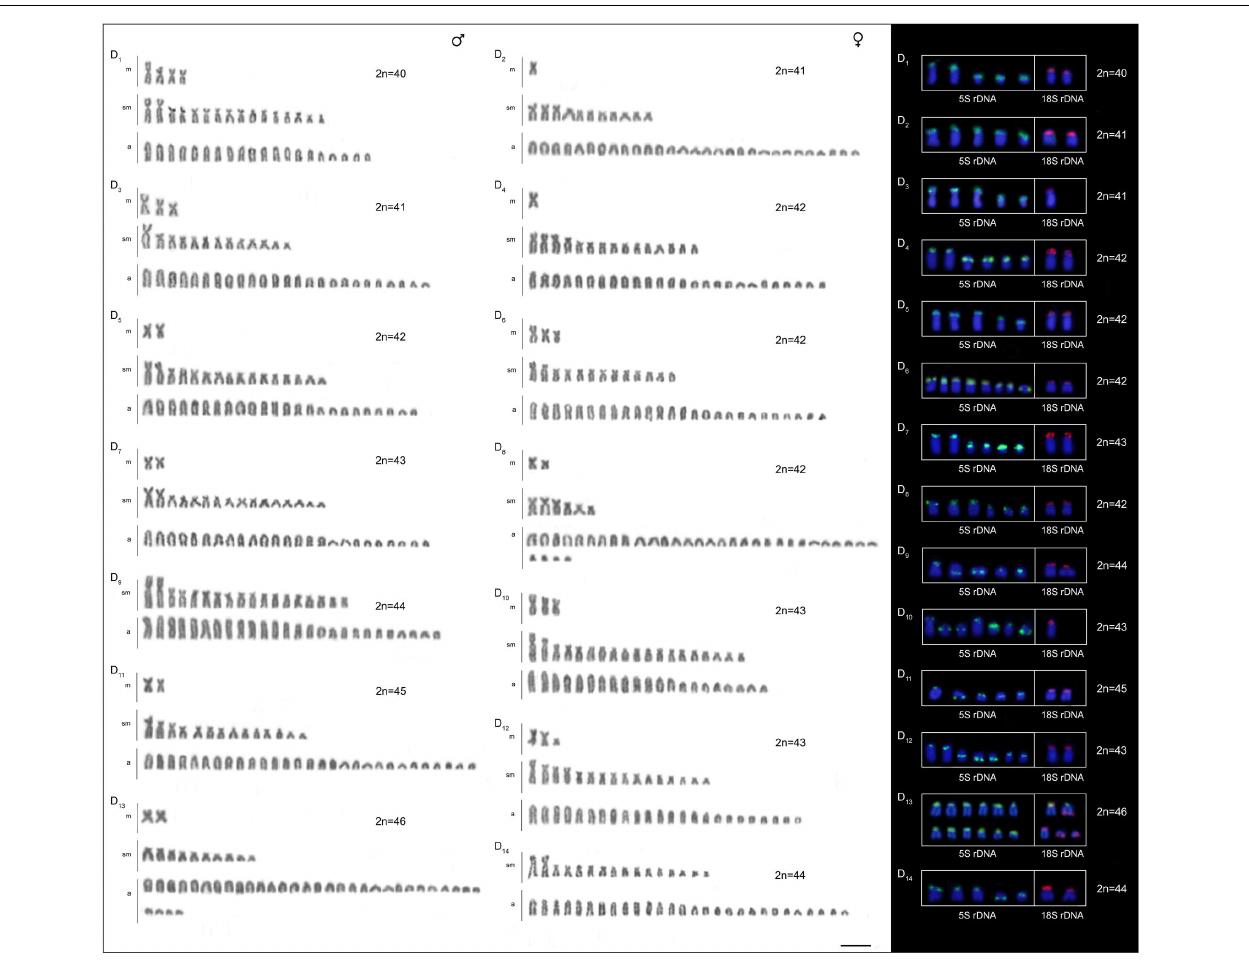
FIGURE 3 | Cytotypes of B. coracoideus ESU-D 1 − 14 Purus River, with Giemsa staining. For this ESU chromosomes were not paired, once no homeology was usually found between the correspondent pairs among the distinct cytotypes. On the right, double-FISH showing the chromosome pairs bearing the 18S rDNA (red) and 5S (green) sequences. Bar = 10 µ